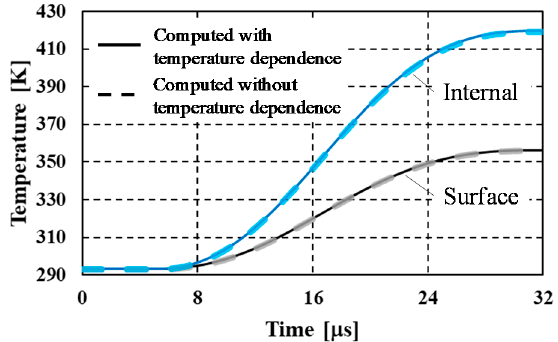
Figure 7. Time variations of FDTD-calculated surface and internal temperatures of the MOV. The initial temperature is set to 293 K.